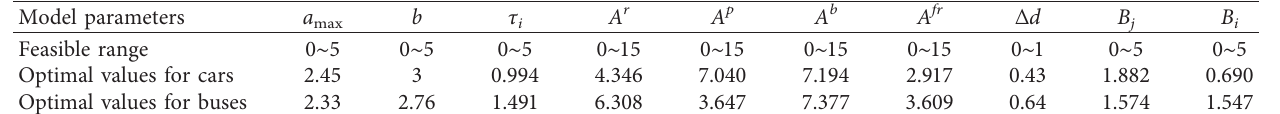
Table 3: Feasible ranges of the parameters and the optimal